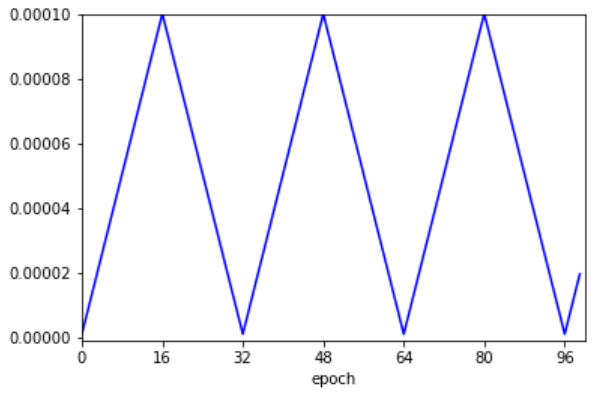
Figure 4. Cyclical learning rate used for training the CNN model.